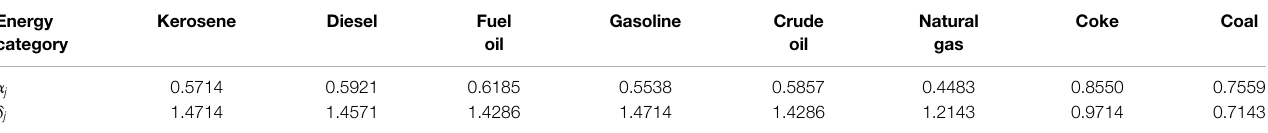
TABLE 1 | Energy conversion coef fi cient and carbon emission coef fi cient. Energy